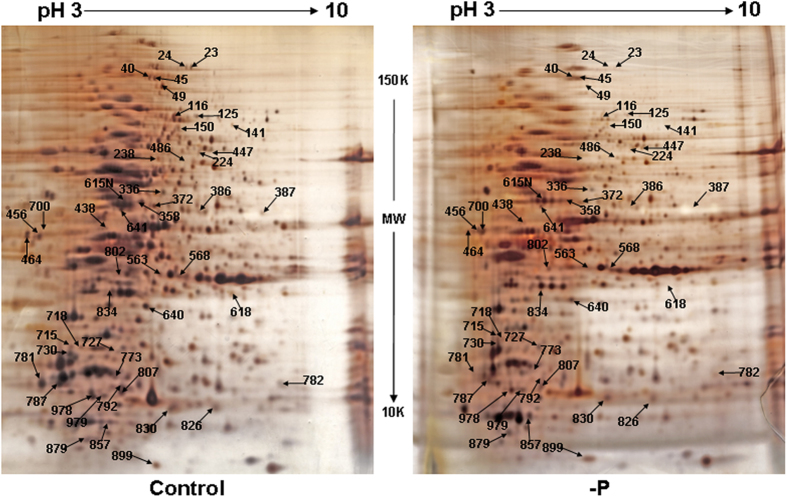
Representative 2-DE gels of diatom proteins of P-replete (control) and P-deprived (-P) cultures. Left: control; right: -P. Molecular weight and pH are indicated at the side and top of gels. Spot numbers are corresponding to that in Table 1.